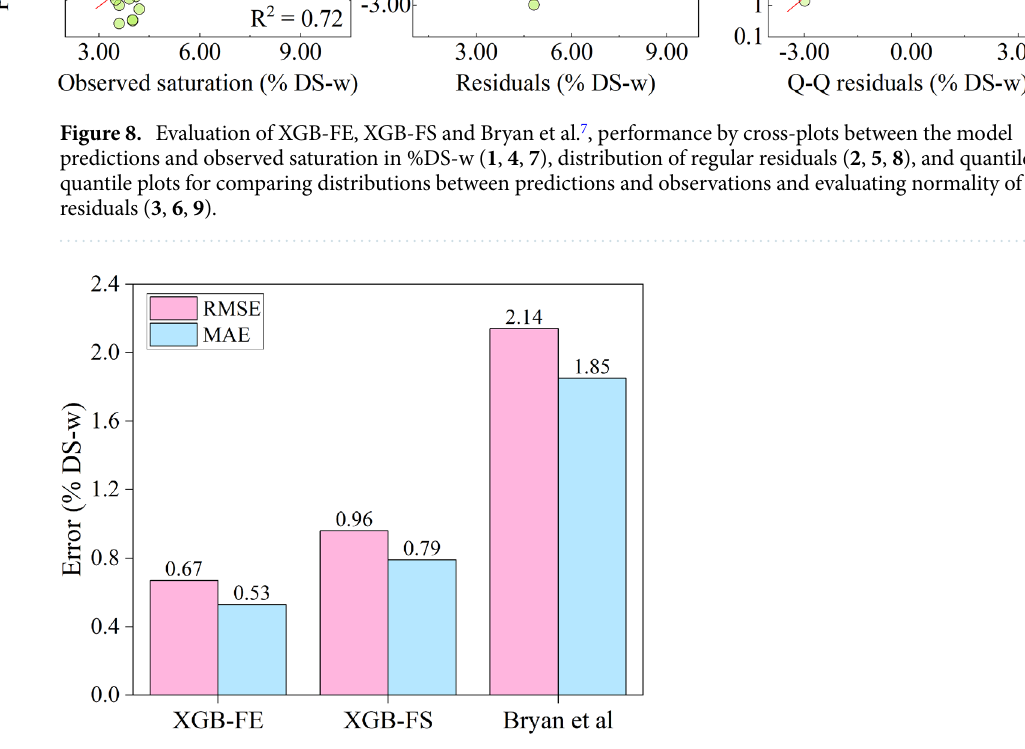
Figure 9. Comparison of RMSE and MAE test prediction scores for the three models ( ‘random_state = 2’